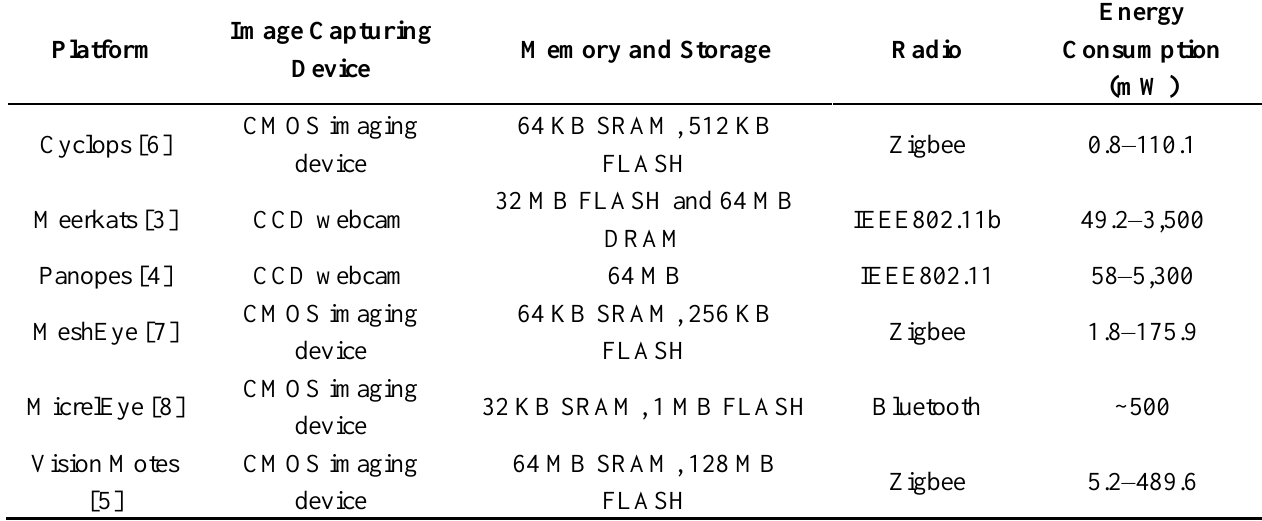
Table 1. Hardware components in WVSN